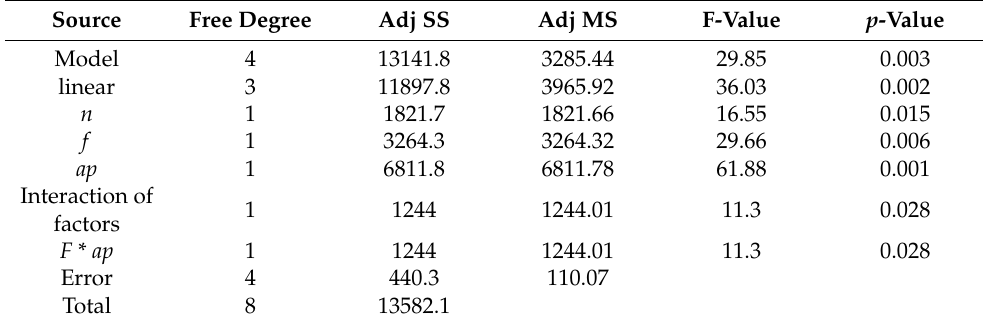
Table 6. ANOVA analysis of variance result table.